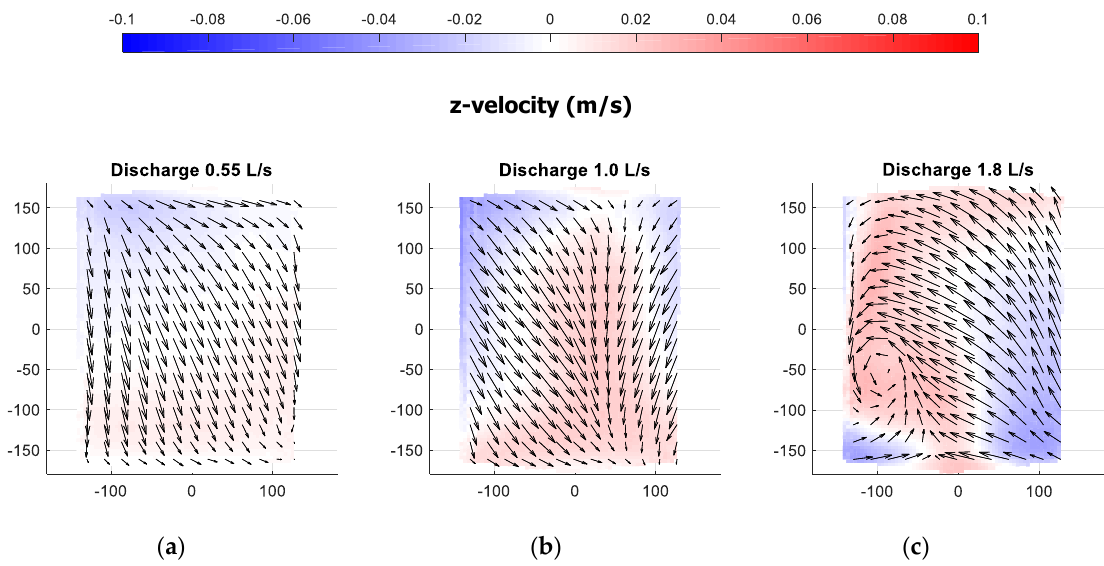
Figure 15. Flow field 3 cm above the gully pot bottom. The outlet is located at the top and the inlet at the bottom of the figures. The arrows indicate the in-plane flow direction and the colour scheme the out of plane component (blue towards the bottom and red towards the water surface). ( a ) Discharge 0.55 L/s; ( b ) Discharge 1.0 L/s; ( c ) Discharge 1.8 L/s.